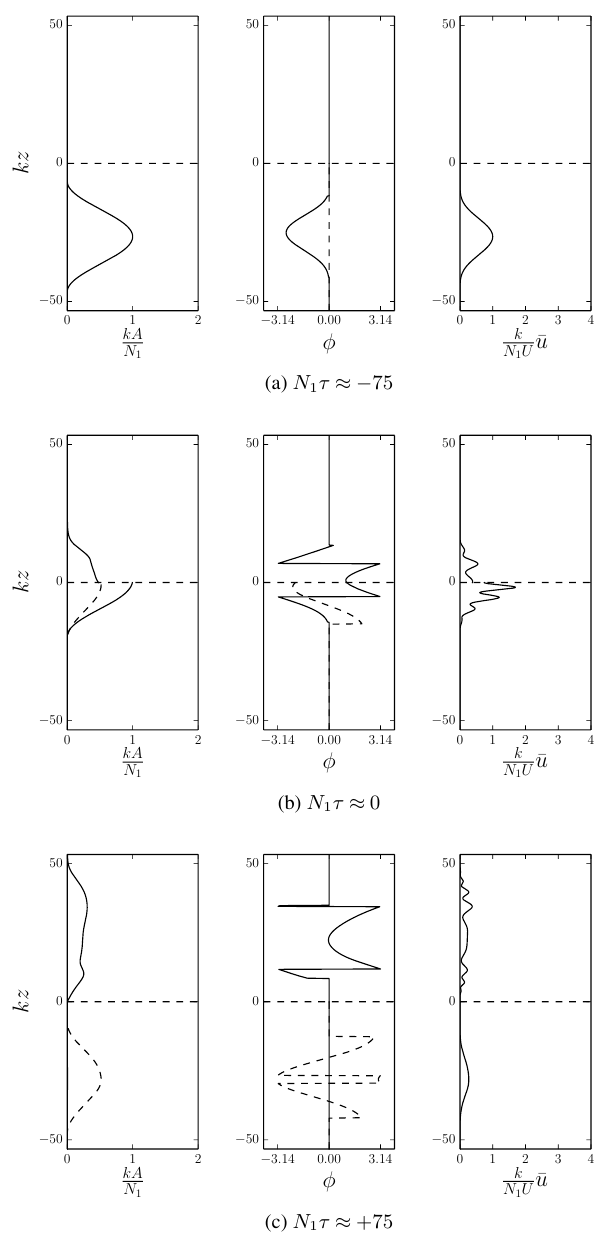
Figure 3. Vertical profiles of the wave magnitudes A (left panel), phases φ (center panel), and mean flow (right panel) at three times in two layers. The parameter values are n 1 /k = 1 / (cid:15) = 0.025, and α = 0.1. The dashed profiles are the magnitude and phase for the downward-moving wave packet (the reflected wave), and the solid profiles are the upward-moving waves (incident and transmitted